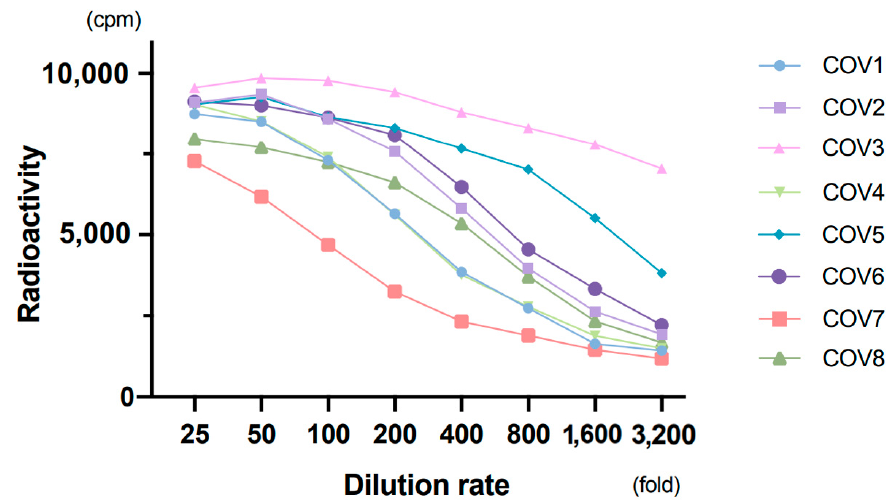
Figure 2. Dilution test. Eight samples from patients with coronavirus disease 2019 (COVID-19) were used with two-fold serial dilution.